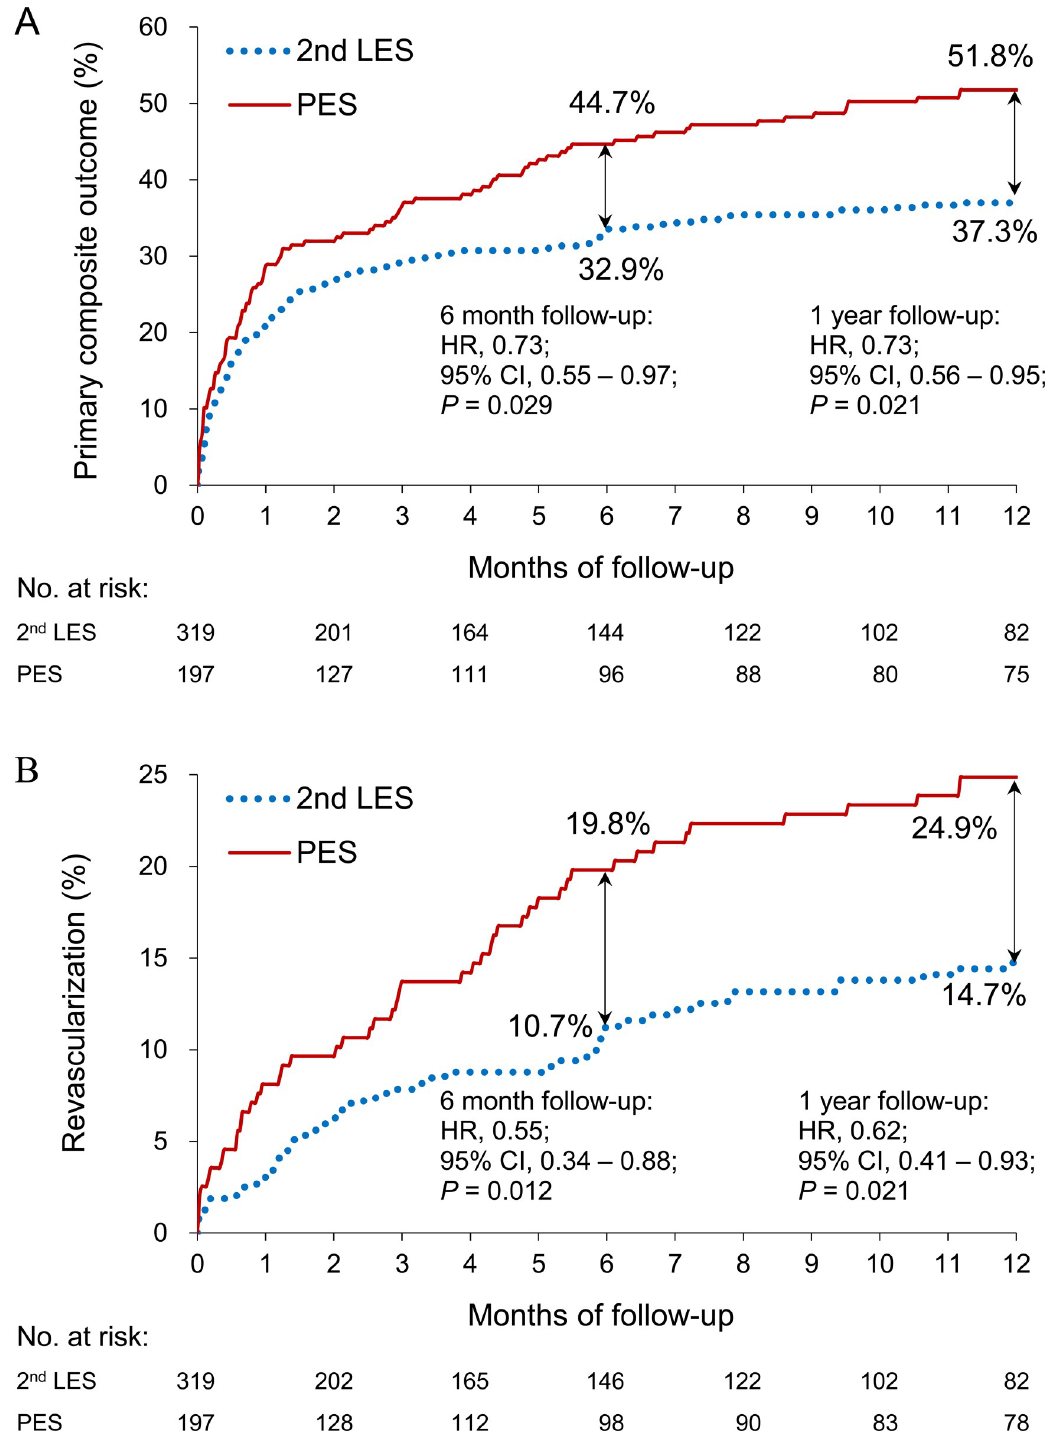
Fig 1. Cumulative event rates of (A) primary composite outcomes and (B) revascularisation during the 6-month and 12-month follow-ups. The primary outcome was a composite of myocardial infarction, coronary revascularisation and cardiovascular death.